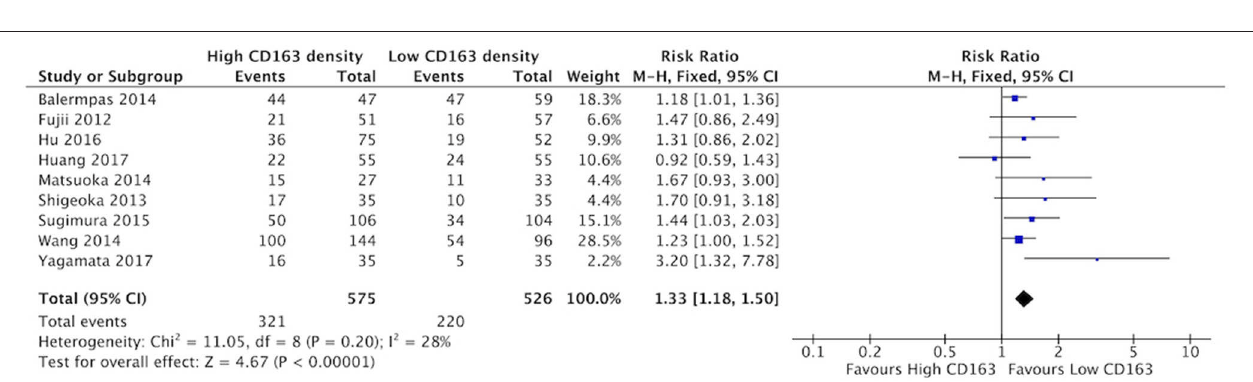
FIGURE 5 | High CD163 + TAM density is associated with nodal positivity.